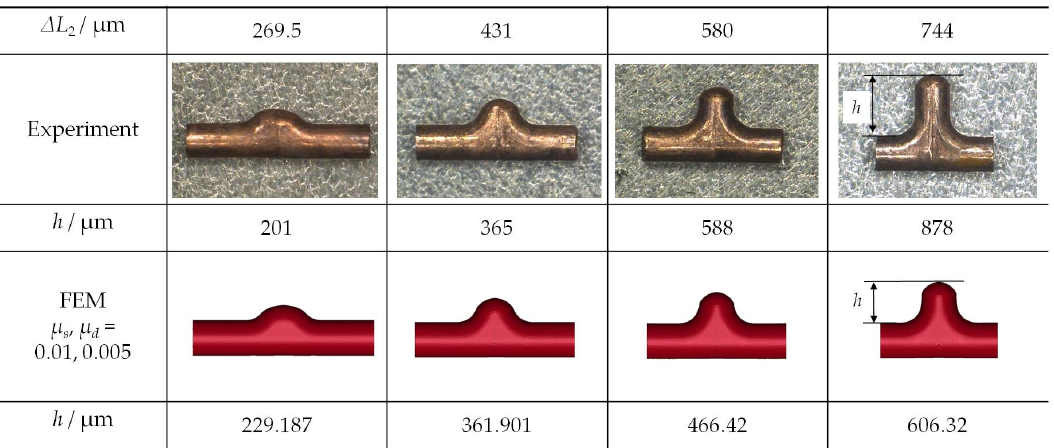
Figure 9. Deformation behavior of microtube in T ‐ shape MTHF ( p h = 50 MPa, μ s = 0.01, μ d = 0.005) (C1220).